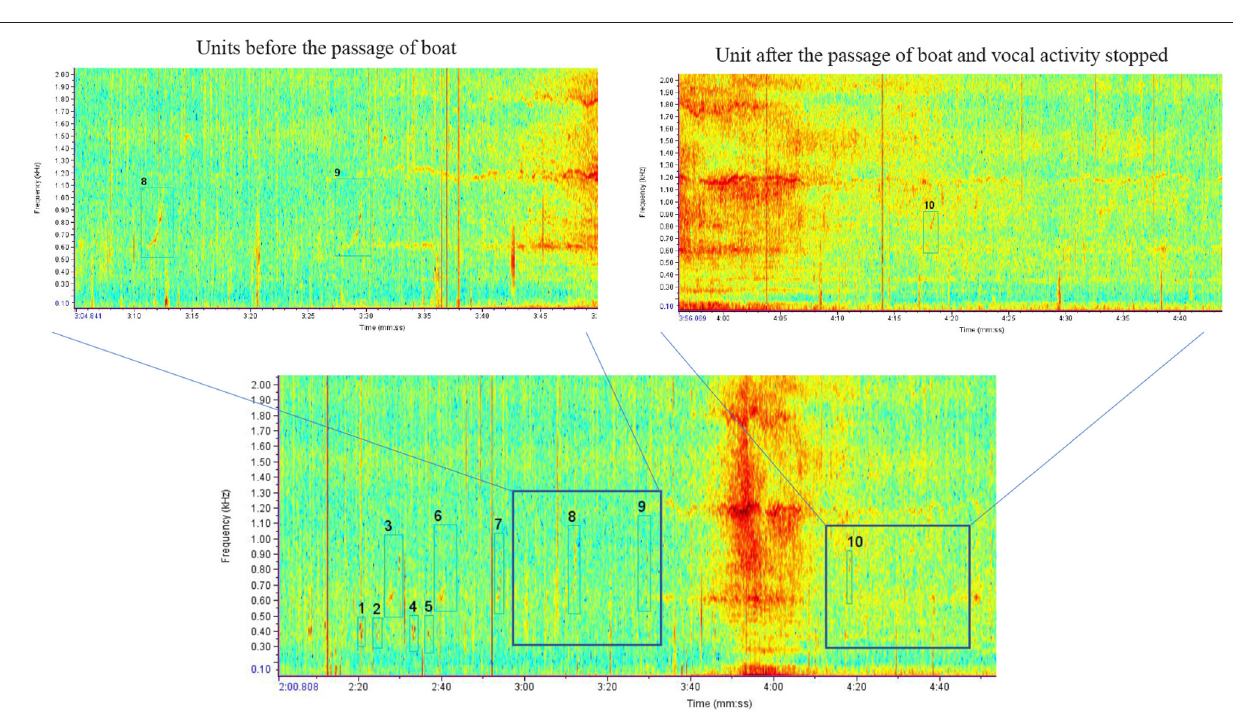
presence of boats is likely partially due to units being masked by boats, so fewer were able to be detected during manual analysis to be included in a rate calculation. This bias in this song rate metric will be discussed